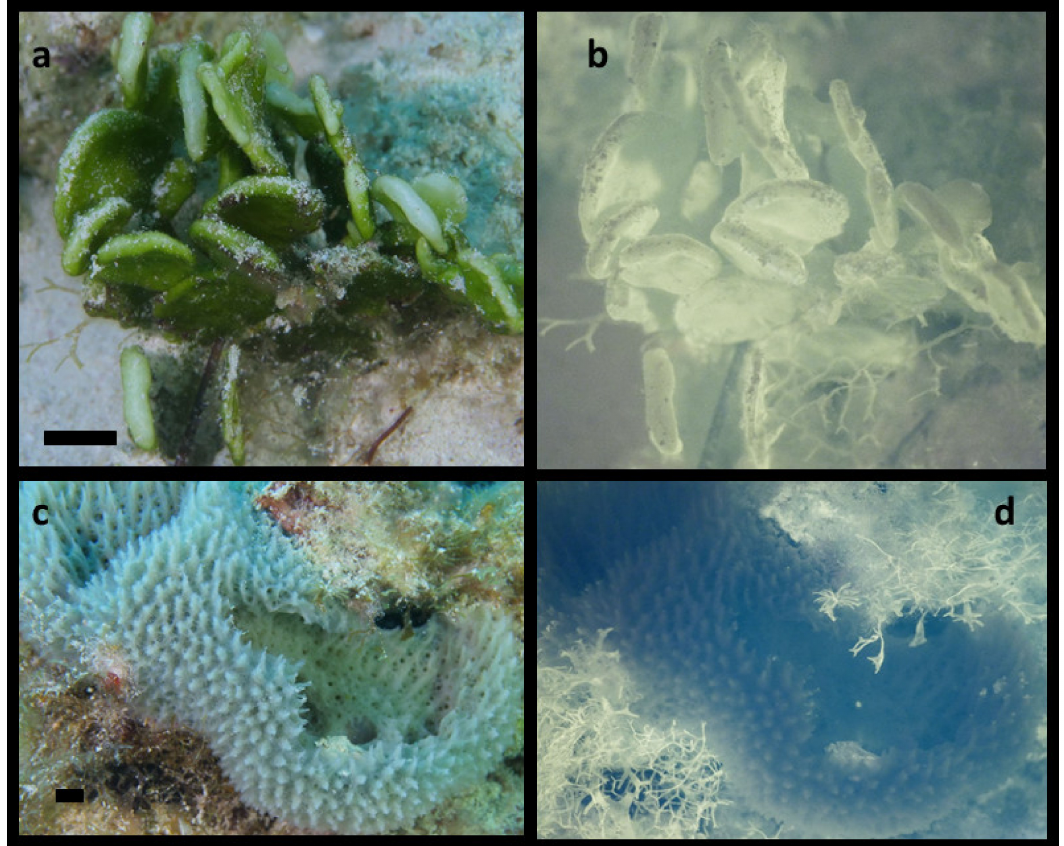
Figure 2. Positive and negative controls for NIR fluorescence imaging. ( a ) Visible image of green algae Halimeda discoidea . ( b ) NIR-image shows intense fluorescence from chlorophyll. ( c ) Non-photosynthetic sponge. ( d ) NIR-fluorescence image shows marine plants growing on the bottom over the edge of the sponge fluoresce, but the sponge does not. The ISO, f / stop are the same in b and d, but the shutter speed in d was twice as long. Scale bars in visible light images are approximately 10